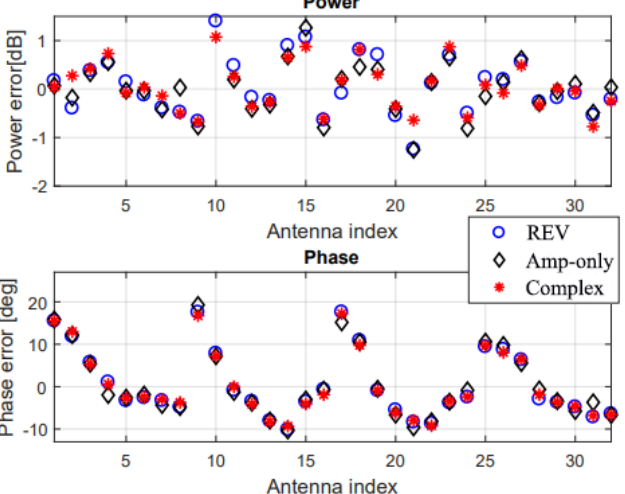
Figure 14. Array calibration errors based on three methods with scattering parameters obtained via geometry configuration ( R = 1